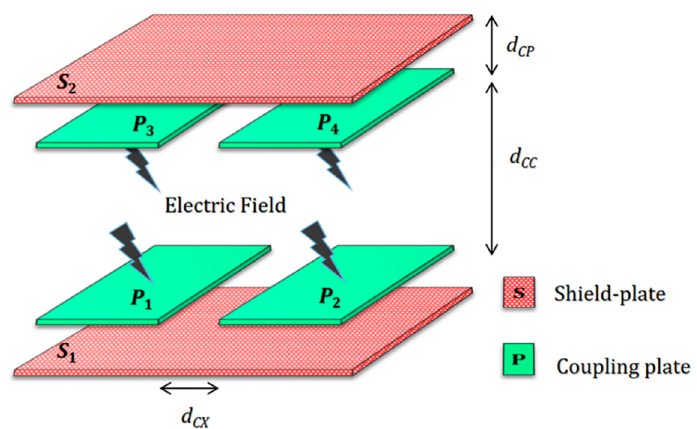
Figure 1. Structure of shielded-capacitive power transfer (CPT) coupling-interface system.